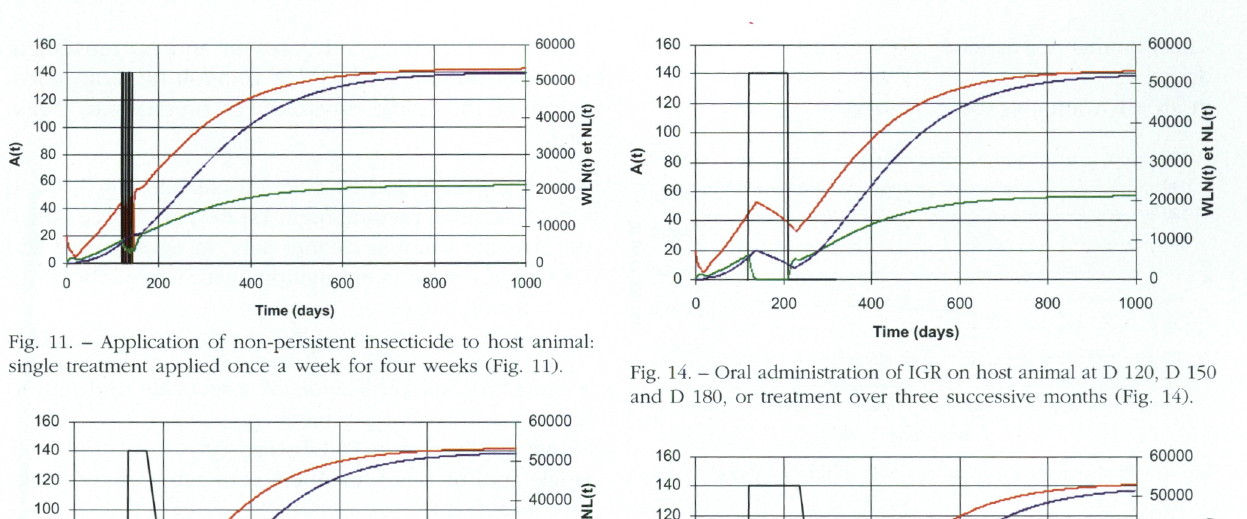
Fig. 15. - Topical administration of IGR on host animal: adminis­ tration at D 120 and at D 180.